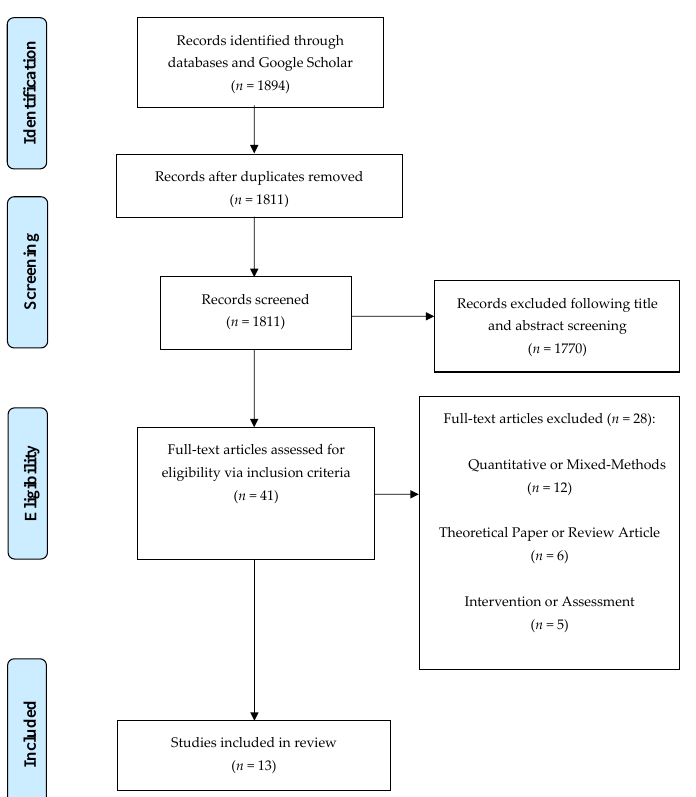
Figure 1. Preferred Reporting Items for Systematic Reviews and Meta-analyses (PRISMA) flow diagram [23].